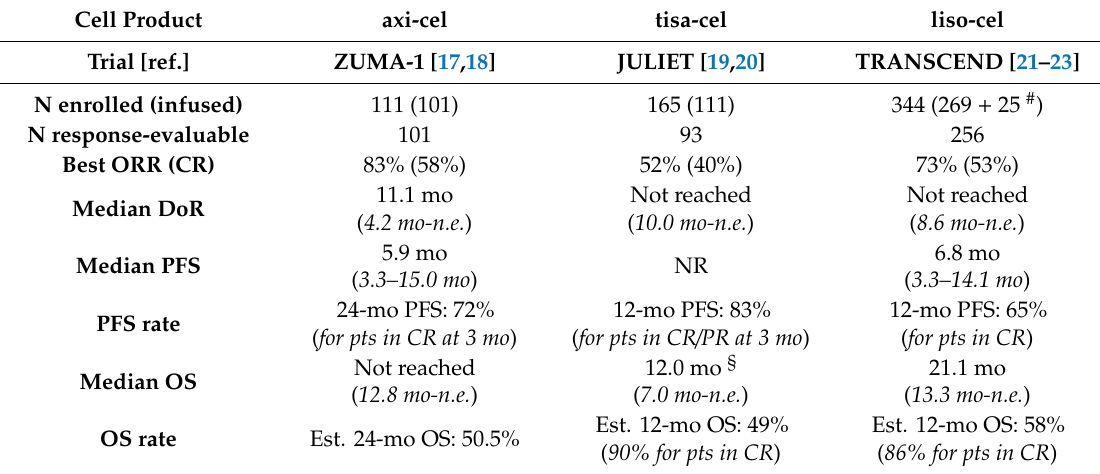
Table 1. E ffi cacy data of CD19-targeted CAR-T-cell therapies axi-cel, tisa-cel, and liso-cel in NHL. Cell Product axi-cel tisa-cel liso-cel Trial